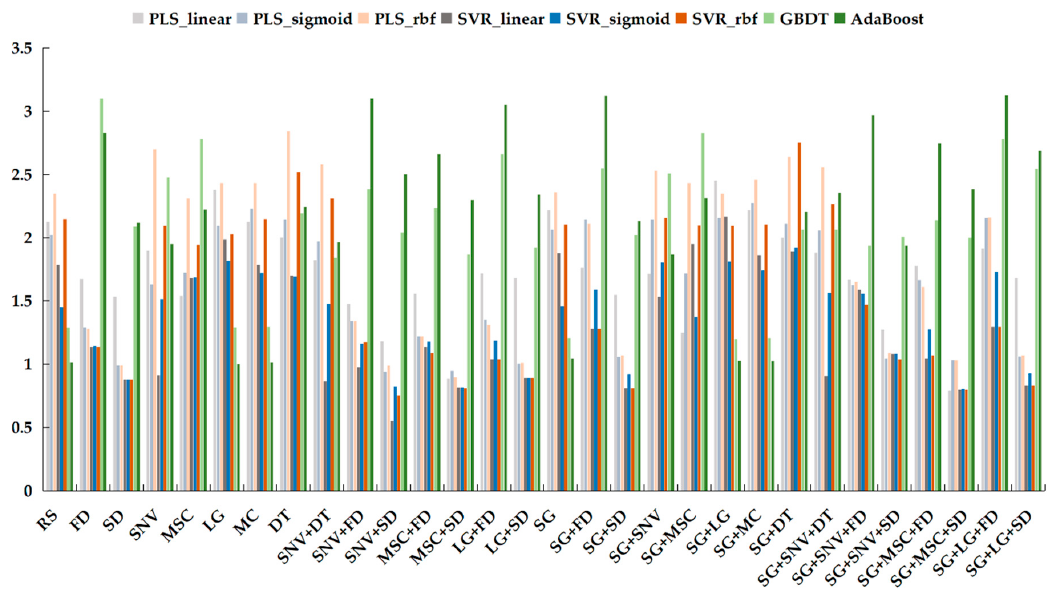
Figure 6. Ratio of performance to interquartile distance (RPIQ) value of regression models with di ff erent pretreatment